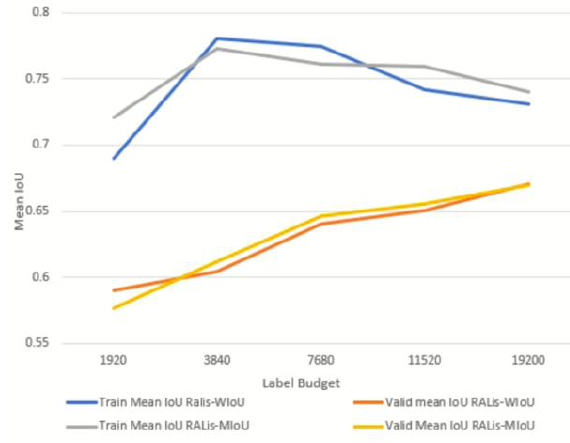
Figure 6. Training and Validation IoU